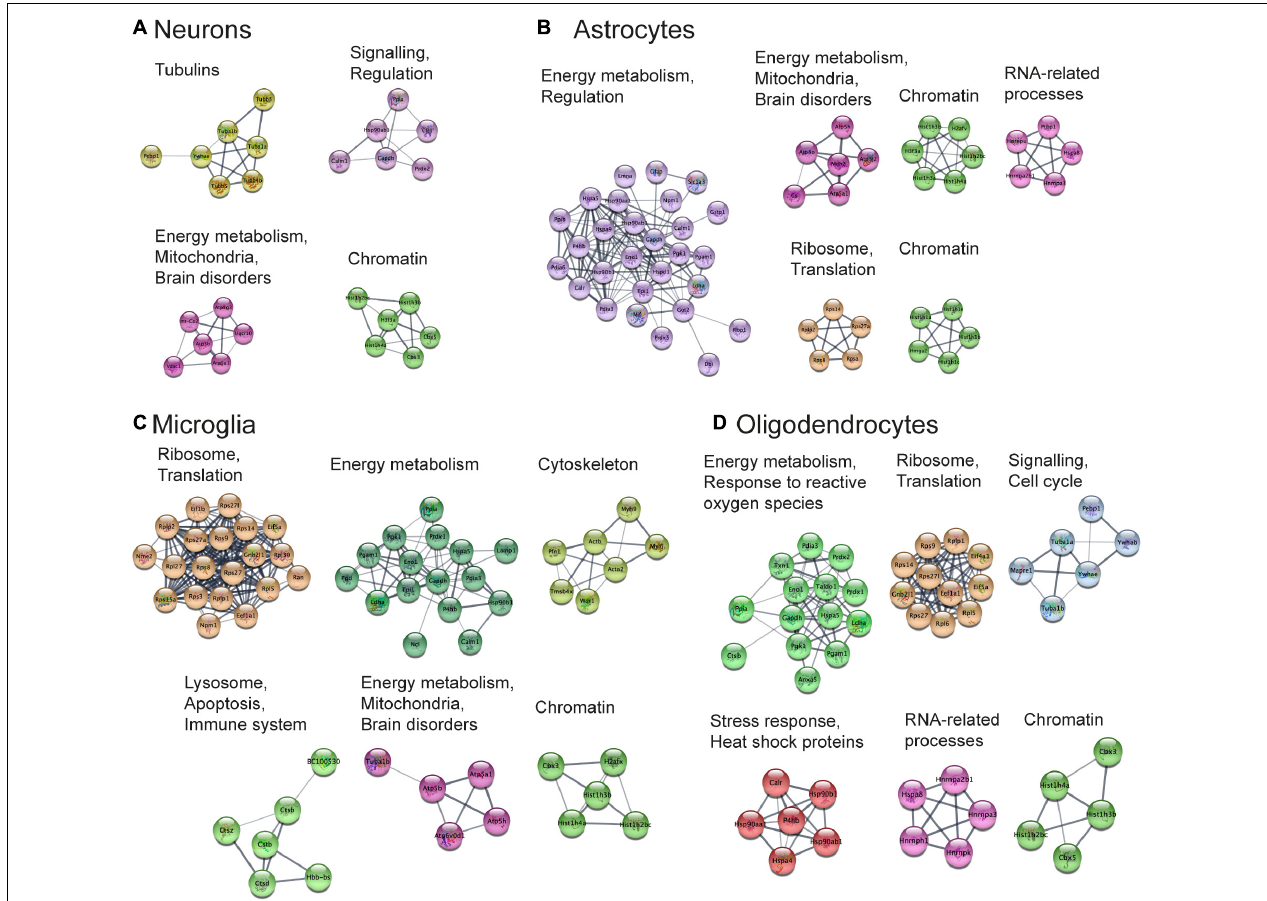
FIGURE 7 | Functional analysis of the most expressed proteins highlights shared functions in different cell types. Networks of the most expressed proteins in different cell types. (A–D) Nodes represent proteins. Edges correspond to all known relations between proteins based on STRING-Cytoscape (Shannon, 2003; Doncheva et al., 2019; Szklarczyk et al., 2019). Only clusters with more than four nodes are shown. The version of this figure with labels shown using bigger font size is available from the Supplementary Presentation for better readability of the